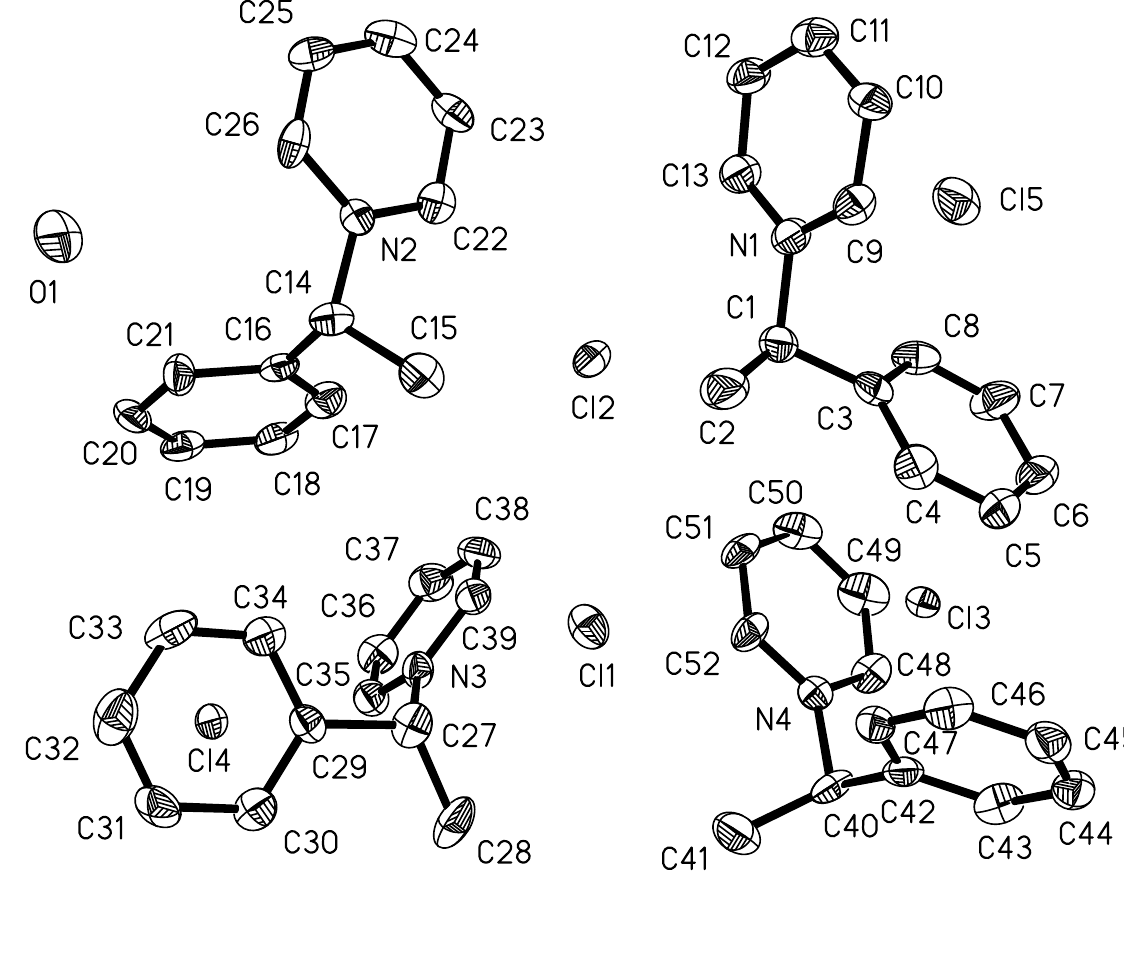
Figure 2. Molecular structure and atom labelling scheme of 1R with thermal ellipsoids drawn at the 50 % probability level (hydrogen atoms are not